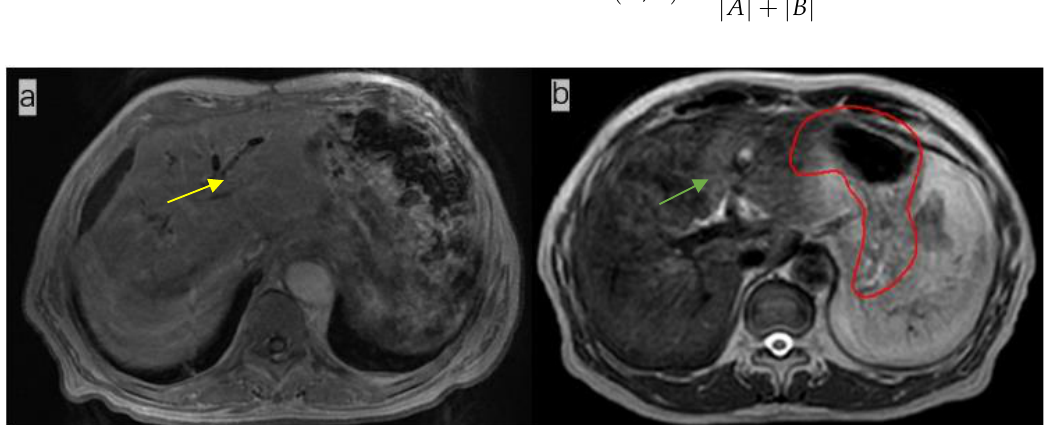
Figure 1. ( a ). Magnetic resonance image (MRI) of a patient (not the patient treated in this study) not treated with anisodamine; notice that the outline of the stomach is blurred (yellow arrow); ( b ) MR image of the patient treated with anisodamine; notice that the outline of the stomach is clearer (green arrow; the red line indicates the contours of the whole stomach).